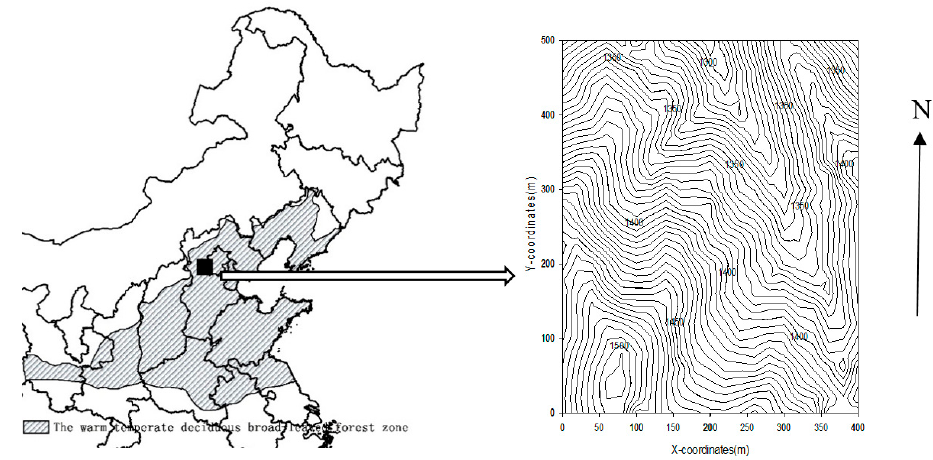
Figure 1. Location and contour map of the 20-ha (400 × 500 m) Dongling Moutain temperate forest plot.